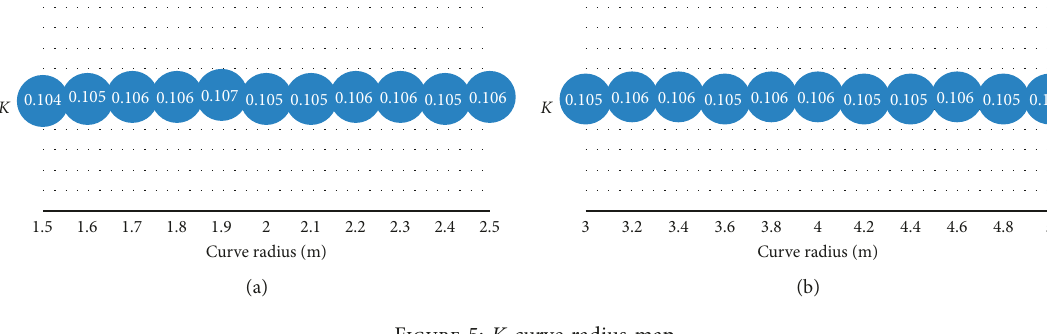
Figure 5: K -curve radius